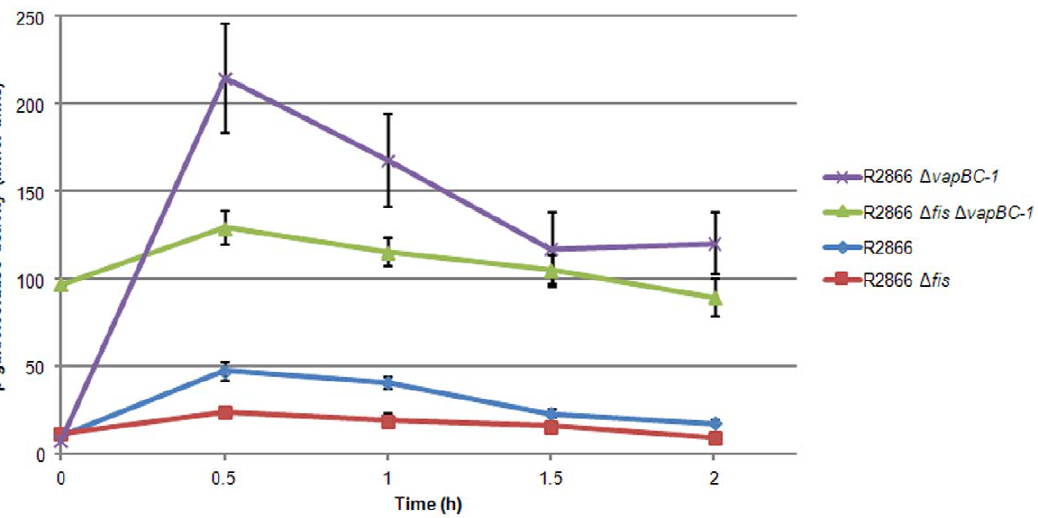
Figure 2. Expression from the NTHi vapBC-1 promoter. b -galactosidase activity indicating lacZ expression under vapBC-1 promoter control in wild type R2866 (diamonds), and R2866 mutants, D fis (squares), D vapBC-1 (crosses), and D fis D vapBC-1 (triangles), was measured every 30 minutes for 2 hours after nutrient upshift. The zero time point indicates expression in the stationary phase culture prior to dilution into fresh media. Each data point is the average of three independent assays performed in triplicate. Error bars are standard deviations.